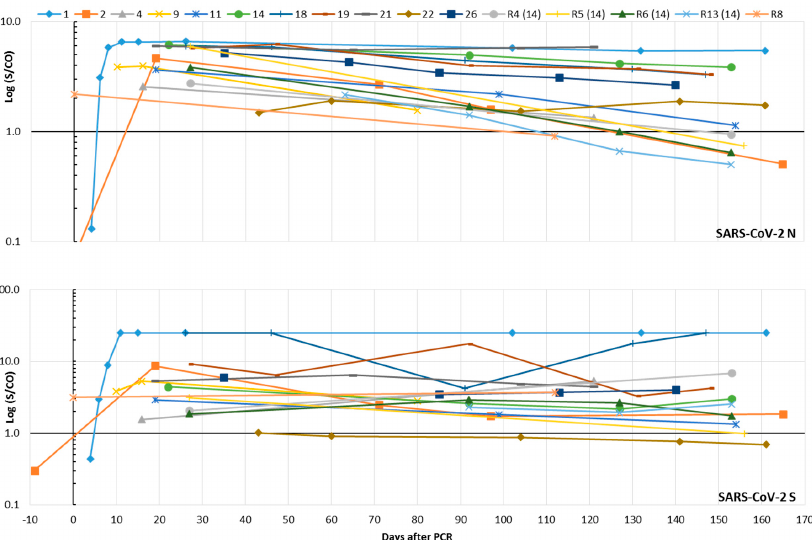
Figure 4. Time course of SARS-CoV-2 IgG in eleven SARS-CoV-2-infected patients and five routine (R) patients (including four family members of SARS-CoV-2 patient no. 14) who were interested in their SARS-CoV-2 antibody status. A signal (S) / cut-o ff (CO) value ≥ 1 is considered as positive for SARS-CoV-2 IgG. The results of the Abbott assay (N protein as the epitope) can be found in the upper part of the figure; those of the Virion-Serion assay (S protein as the epitope) are given below. Results from the validation part of this study were